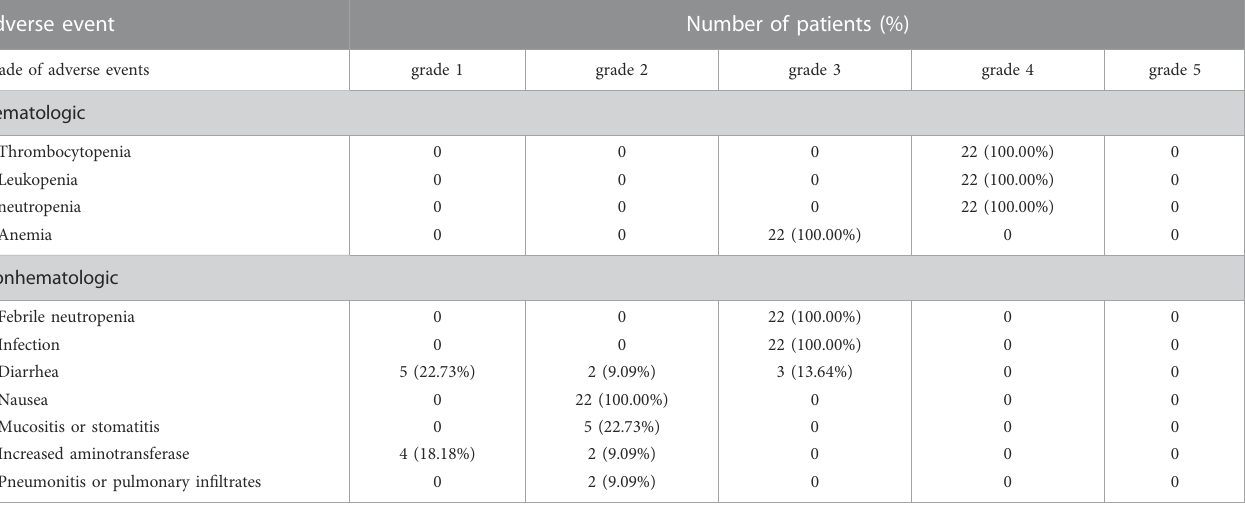
TABLE 3 Summary of adverse